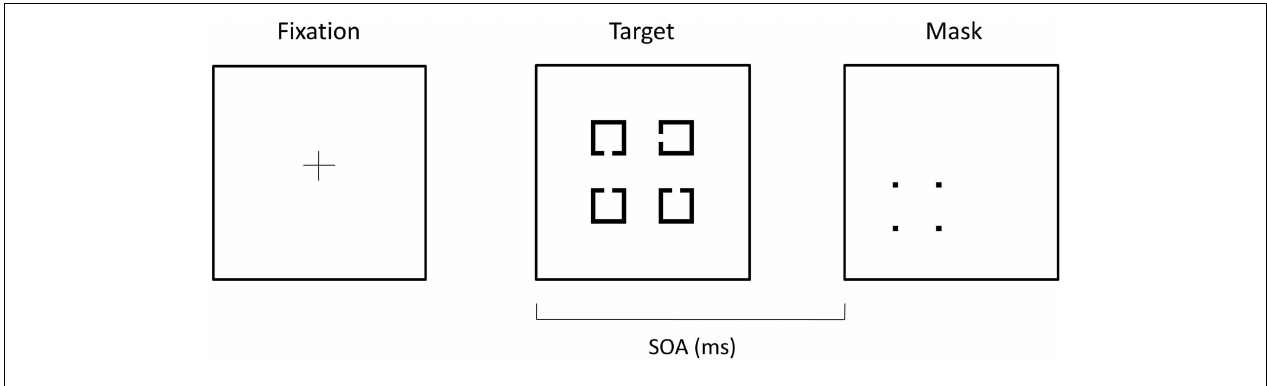
A mask, consisting of four-dots that surrounded one of the potential targets, was presented for 37.5ms.The mask served as the cue to the participant as to which target they were to identify the direction of the